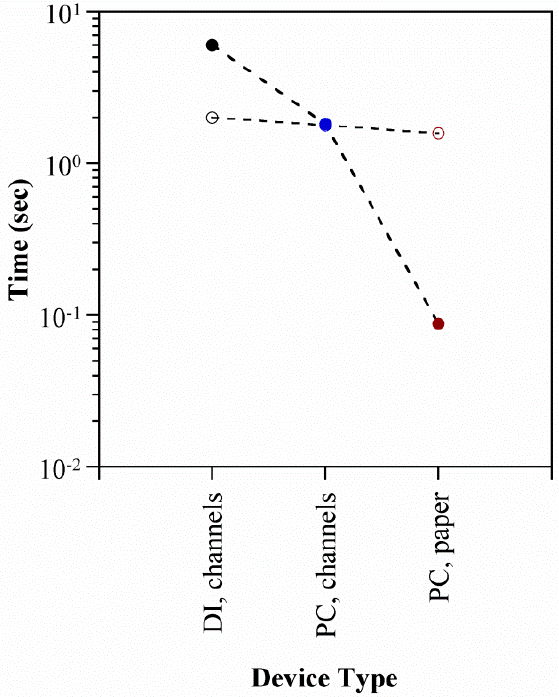
Figure 12. Summary of actuator response times in the paper-based stacked devices and previous microchannel devices using PC and DI water. Filled circles represent inflation and open circles deflation.